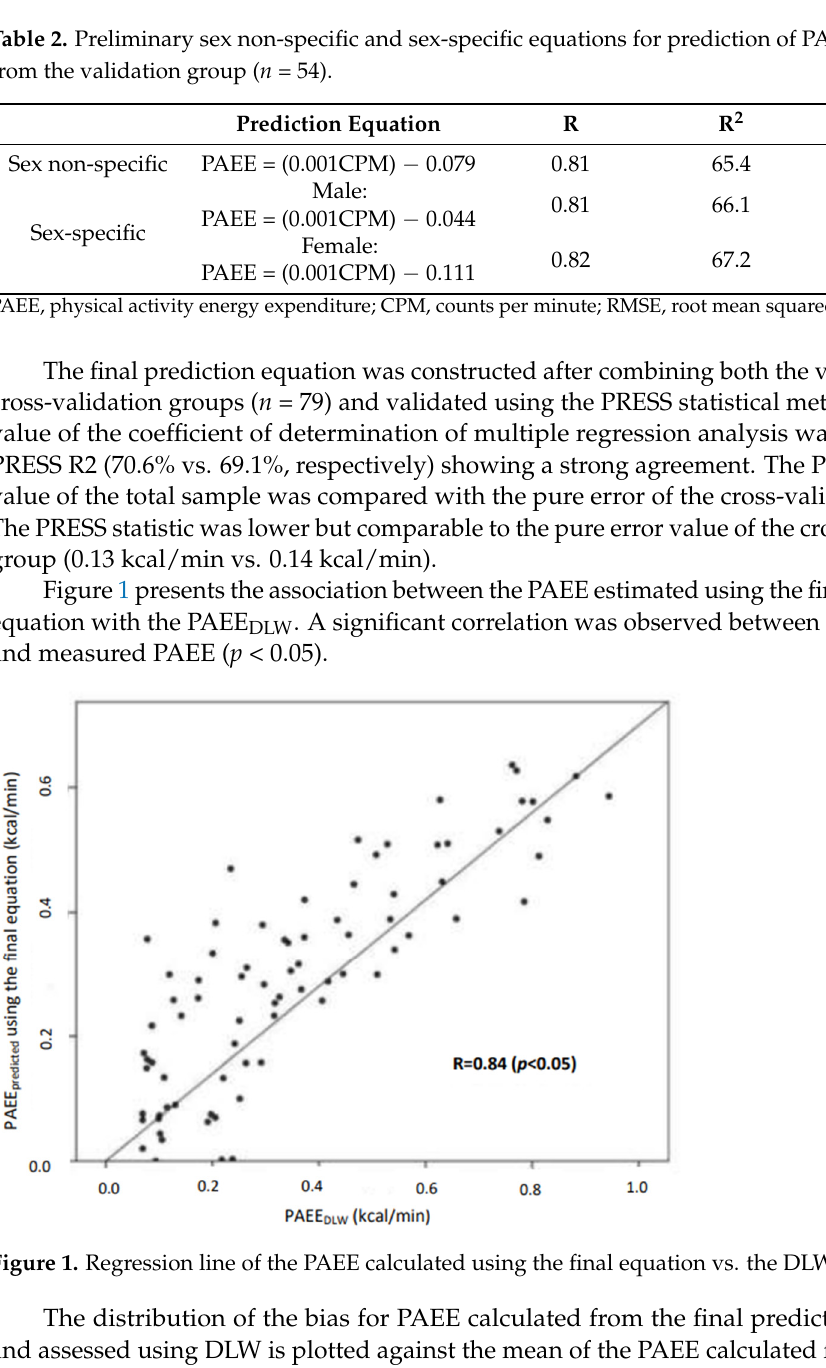
Figure 2. Bland–Altman plots showing bias and average between the PAEE calculated using the criterion method (DLW) and estimated using the final equation. The mid-line indicates the mean